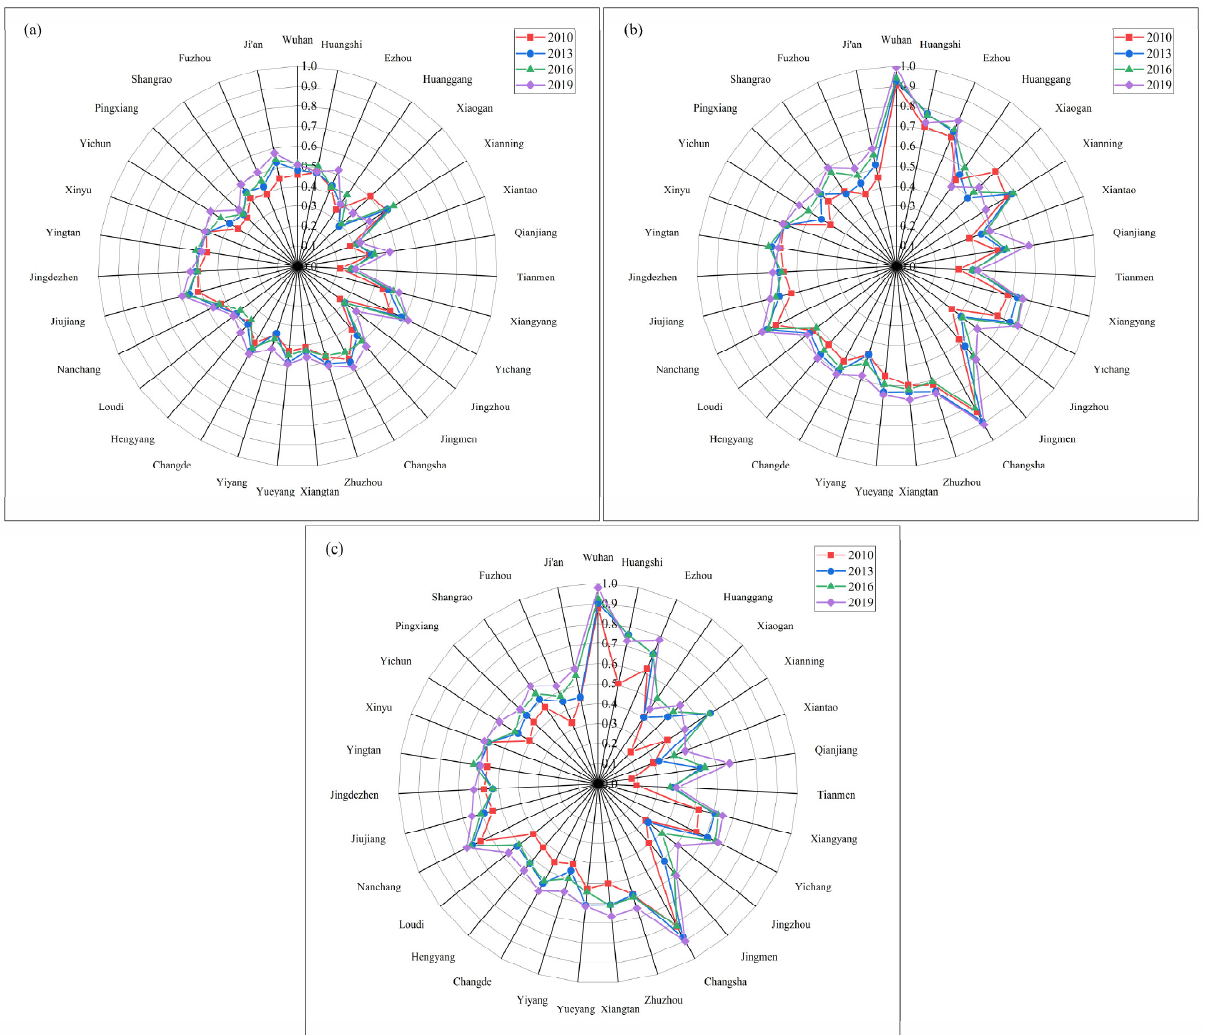
Figure 10. CCD of HQED and the EE subsystem: ( a ) CCD of HQED and the status subsystem; ( b ) HQED and CCD of the pressure subsystem; ( c ) HQED and CCD of the response subsystem.